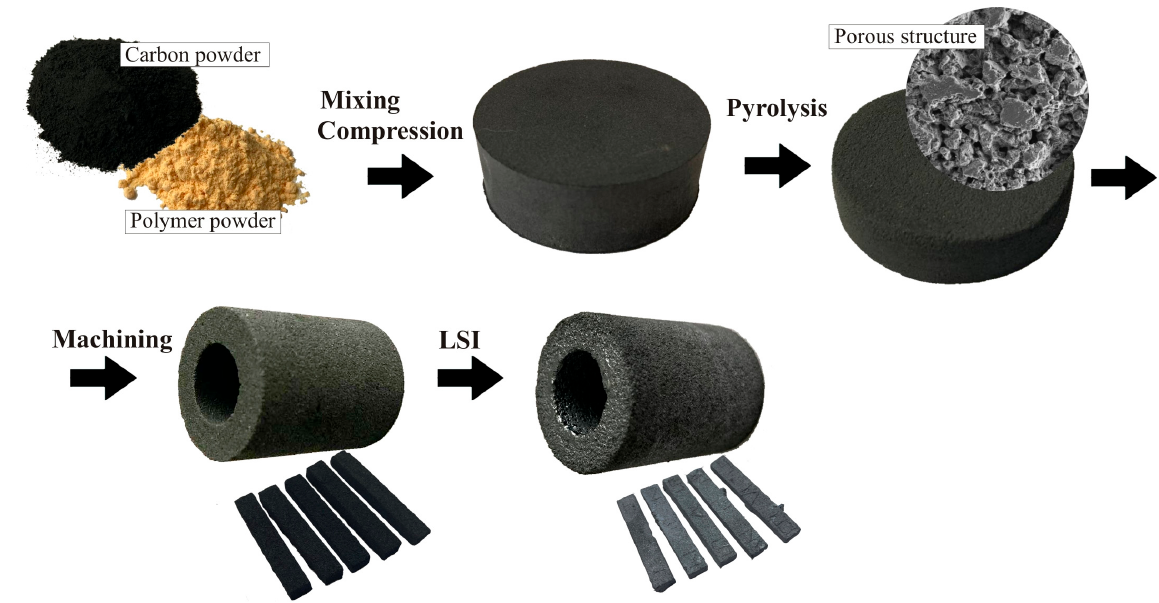
Figure 1. Stages of obtaining products based on SiC ceramics by liquid silicon infiltration (LSI) of porous carbon blanks.